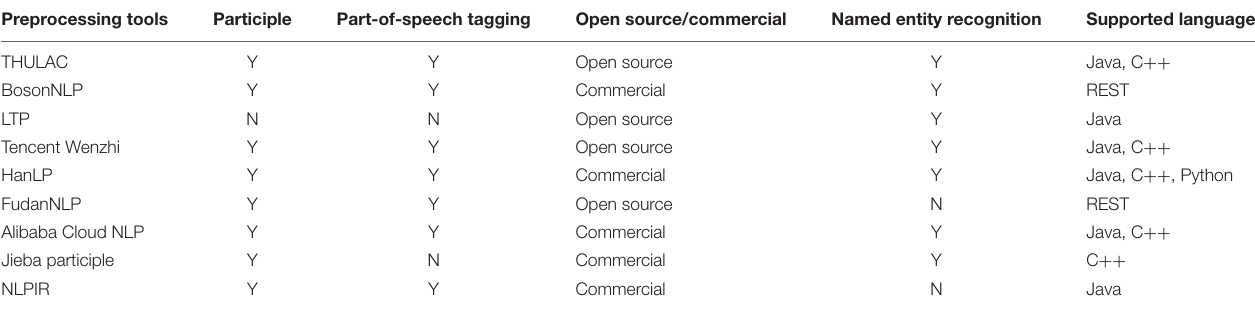
TABLE 1 | Chinese preprocessing